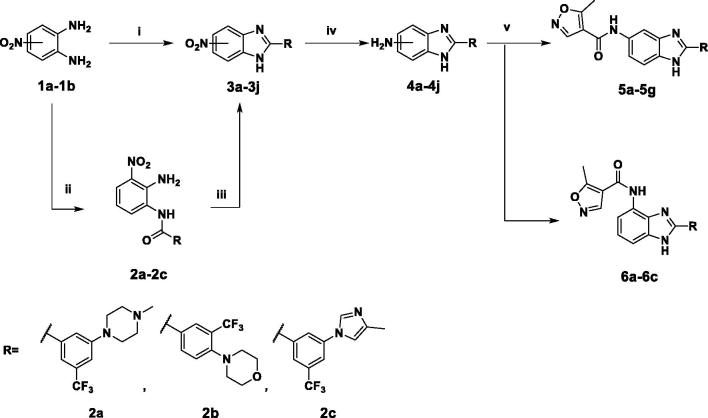
Synthesis of 1H-benzimidazolyl isoxazole-4-carboxamide derivatives. (i) benzoic acid, POCl3, µW, 192 °C, 10 min for 3a–3g; (ii) benzoyl chloride, MC/CAN = 2:1, rt, 2 h; (iii) HCl/H2O/AcOH, 150 °C, 30 min for 3h–3j; (iv) H2 , Pd/C, MeOH 1 h for 4a, 4b, 4c, 4g, 4h, 4i or SnCl2, EtOH, 90 °C, 1 h for 4d, 4e, 4f or Fe, AcOH/H2O/EtOH, 60 °C for 4j; (v) 5-methylisoxazole-4-carbonyl chloride, THF, 65 °C, 1 h